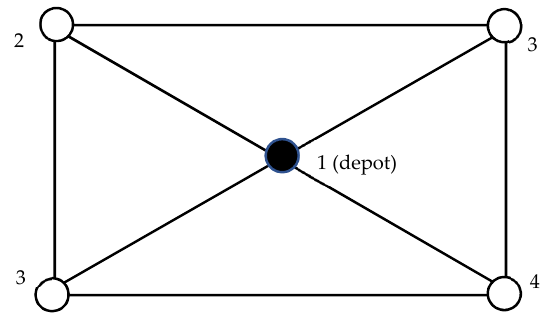
Figure 4. Test Figure 4. Test network.